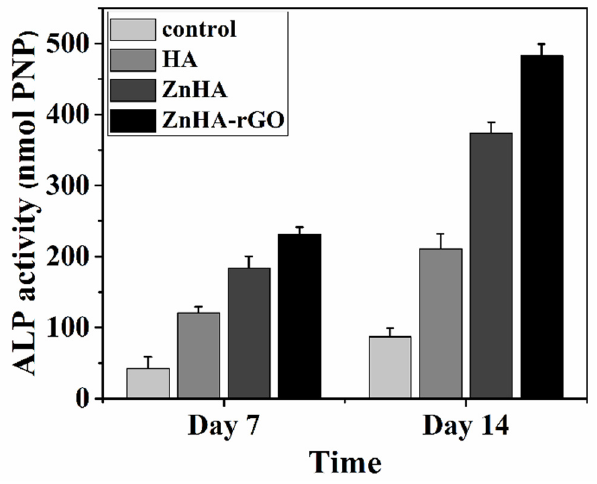
Figure 5. ALP activity of MSCs in cu lture media treated by the HA, ZnHA, and ZnHA-rGO nano- particles. Incubation with ZnHA-rGO nanoparticles for 7 to 14 days significantly induced ALP activity.